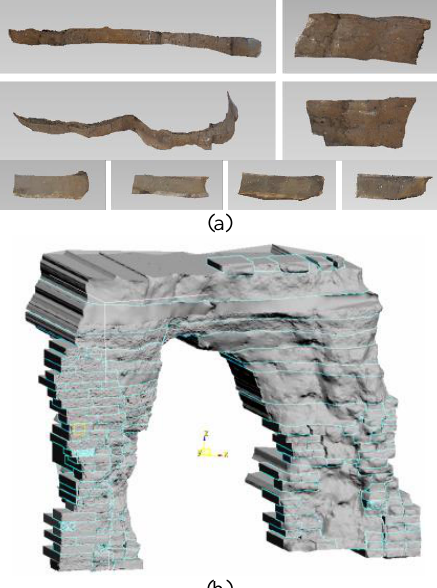
Figure 8. (a) The irregular earth plate; (b) the constructed model of moon gate before